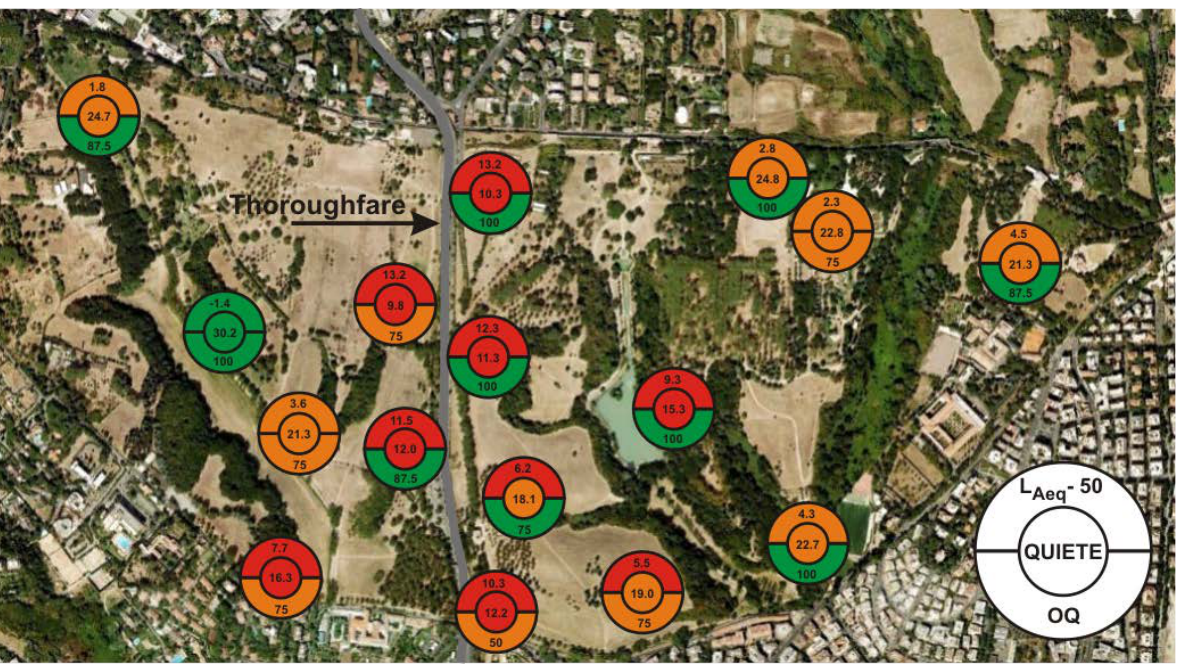
Figure 11: Map of the “Villa Pamphili” park in Rome with its internal areas described by QUIETE and the measured parameters ( L Aeq − L ref and OQ) on the colored scale given in Table